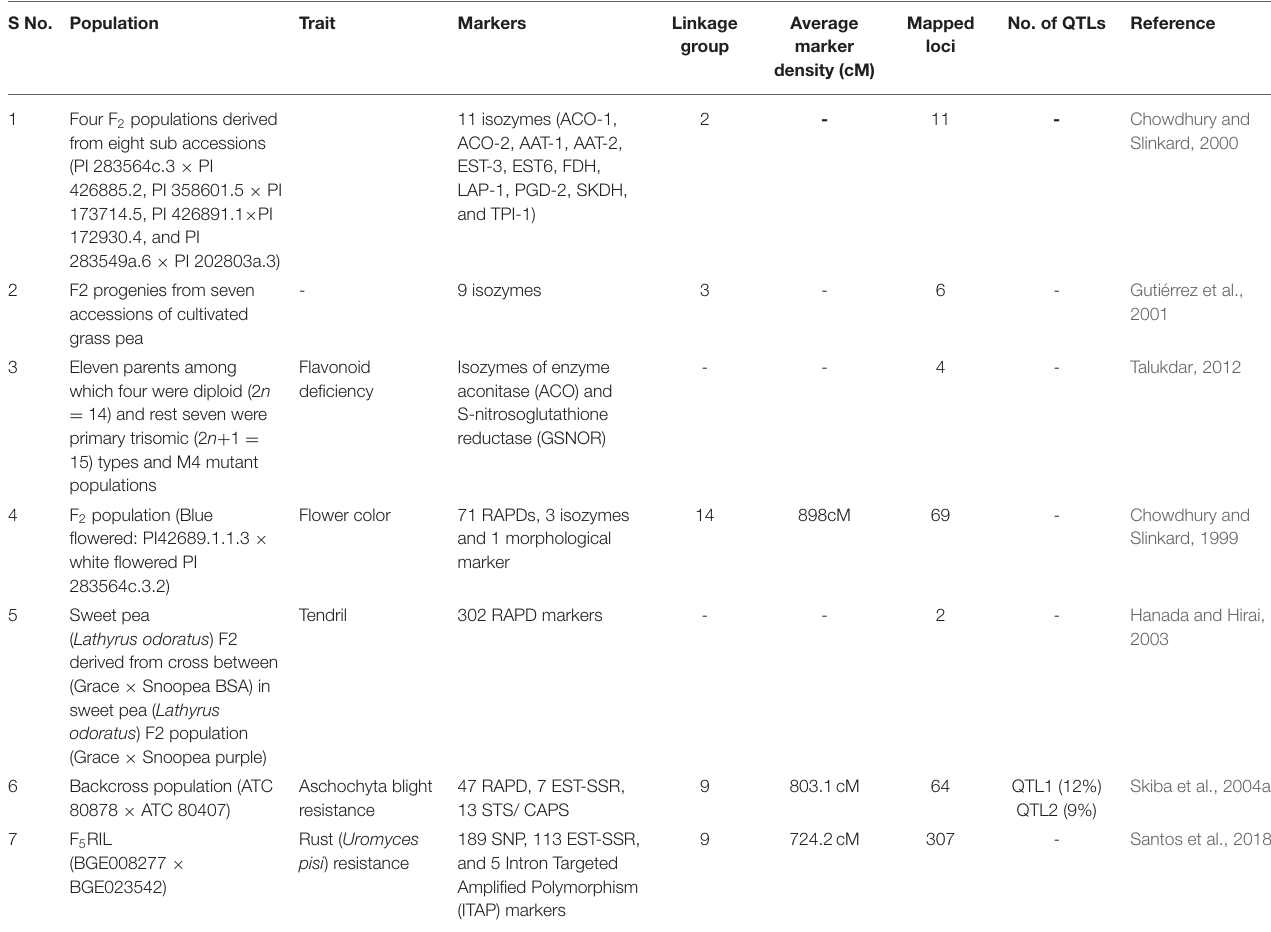
TABLE 3 | Summary of molecular mapping studies carried out in grass pea. S No.